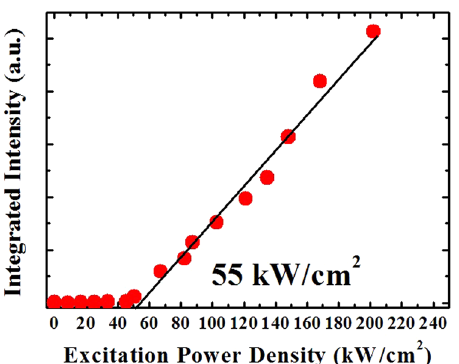
Figure 4. Integrated light intensity of the emission spectra as a function of the excitation optical power